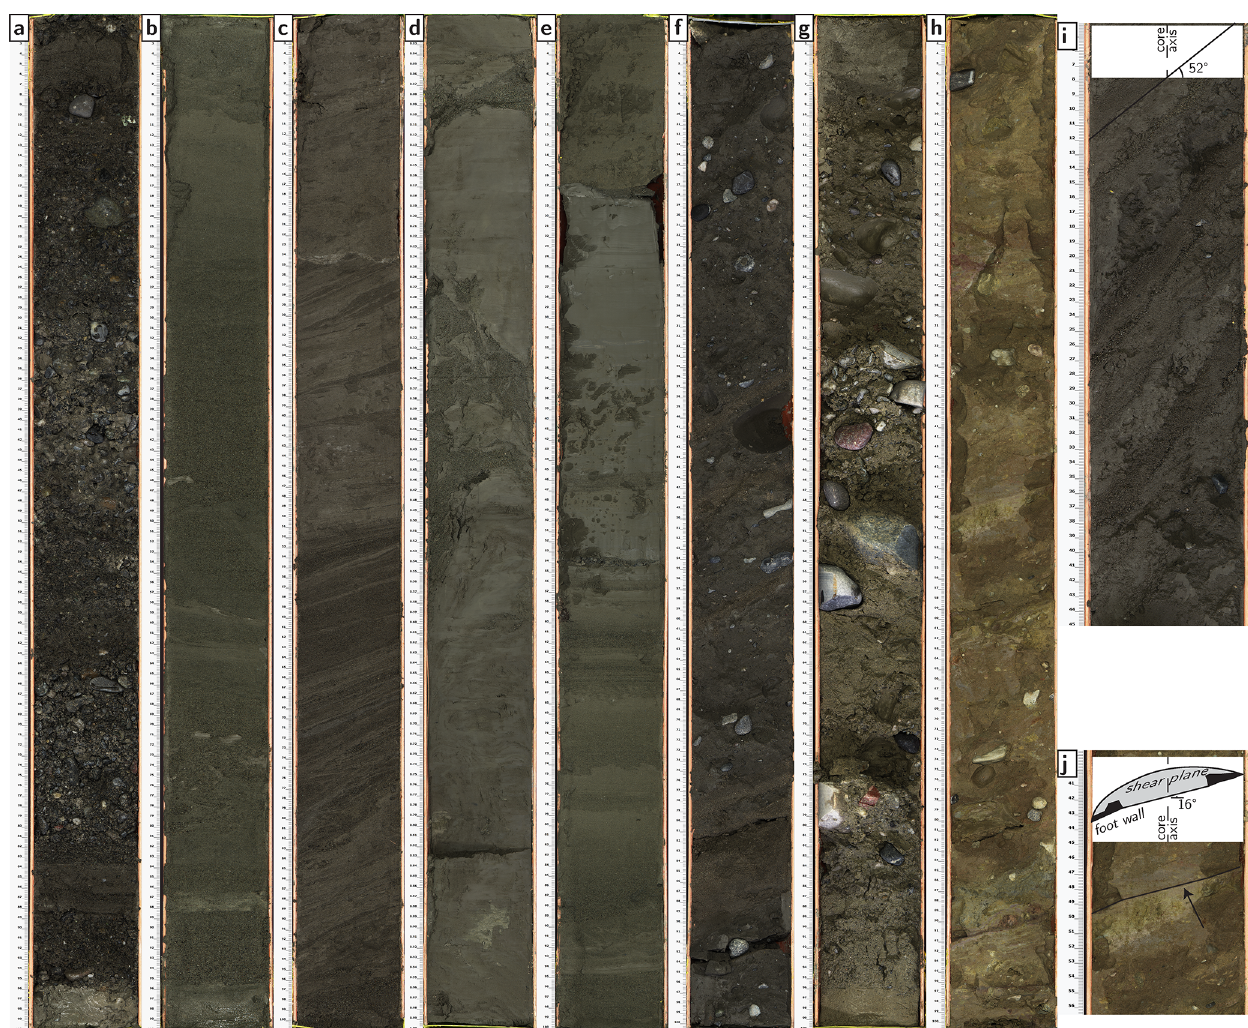
Figure 5. Photos of eight illustrative core sections. For lithofacies descriptions, see Appendix A and Table 1. (a) Ghb, QDR-RE-IfG 175, 170–171m: clast-supported, fine- to medium-grained gravel beds with a sandy and silty matrix and sand interbeds. (b) Shb, QDR-RE-IfG 063, 59–60m: sandy deposits with a distinct normal grading between 10 and 57cm. (c) Slm, QDR-RE-IfG 187, 182–183m: cross-bedded, laminated sand beds. (d) Fdf, QDR-RE-IfG 011, 10–11m: fine-grained sediments showing deformation, most probably due to slumping. (e) Fm, QDR-RE-IfG 043, 39–40m: thick clayey silt layer with a gradual contact atop a normally graded sand. The upper contact is sharp. (f) Dms, QDR-RE-IfG 144, 139–140m: mud beds with outsized clasts showing an inclined bedding and arrays of clasts where the a – b planes are aligned parallel to the bedding. (g) Dmm.2, QDR-RE-IfG 106, 101–102m: upper till void of sedimentary structures. (h) Dmm.1, QDR-RE-IfG 212, 207–208m: lower till showing colored clay bands hosting glaciotectonic shear planes at 49, 60, 81, 90, and 97cm. Note the probably rotated clast at 90cm depth. (i) QDR-RE-IfG 115, 108–109m: example of oversteepened beds. The apparent dip is ca. 52 ◦ . (j) QDR-RE-IfG 212, 207–208m: example of a shear plane (arrow) in Dmm.1. The inset shows the apparent dip of the plane and a